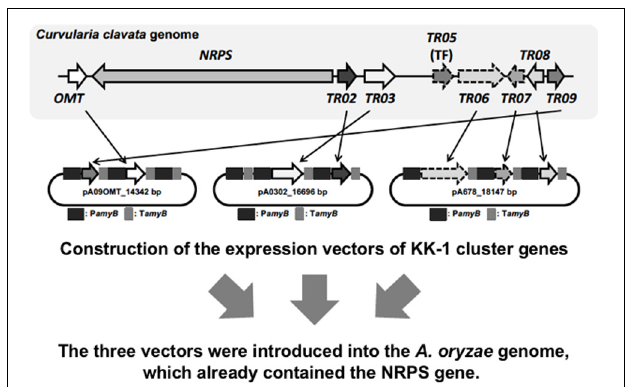
FIGURE 4 | Strategy for introducing all genes involved in KK-1 biosynthesis. Shown is the cloning strategy used to introduce the seven cluster genes into the plasmid pA3AXPC, along with the resulting vectors, pA09OMT, pA0302, and